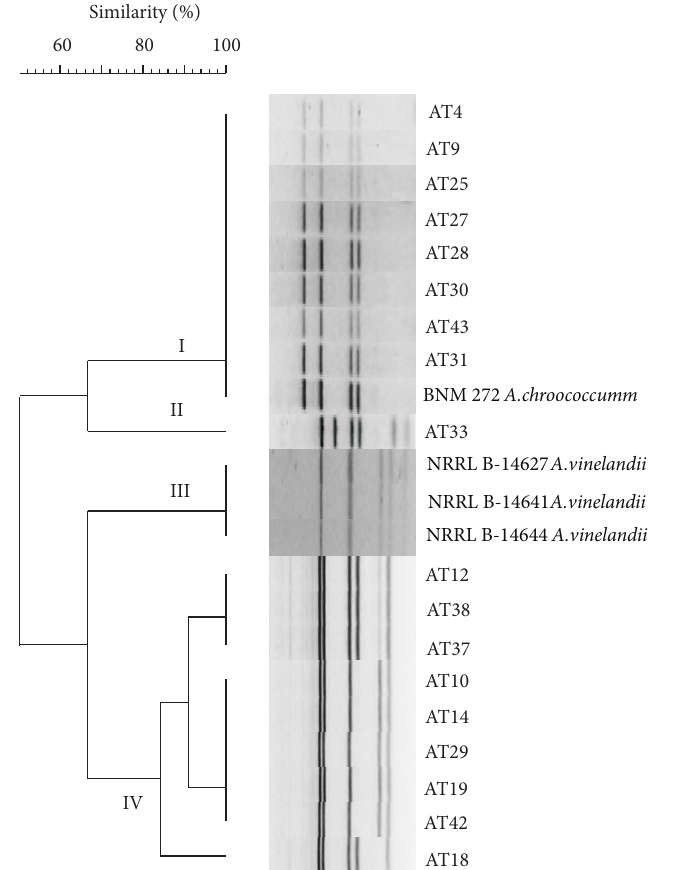
Figure 2: Amplified ribosomal DNA restriction analysis (ARDRA) of Azotobacter representative strains of each rep-PCR group and reference strains. The dendrogram based on analysis of restriction patterns of 16S rDNA obtained with Hha I was built using the GelCompar II program and the Dice ( 𝑆 𝐷 ) pairwise coefficient of similarity and the UPGMA algorithm. Clusters were defined at the 𝑆 𝐷 > 80 % similarity level. The cophenetic correlation value for this dendrogram was